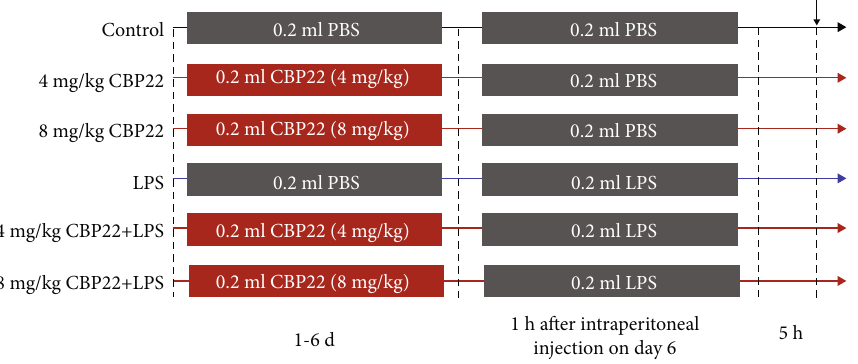
Figure 1: Experimental design and scheme of animal